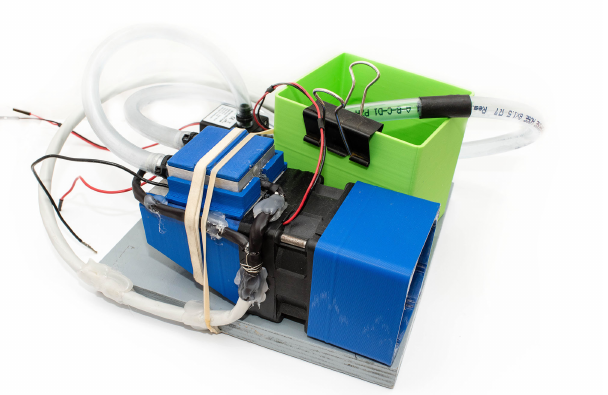
Figure 5. Experimental setup equipped by TEC1-12706. The fan cools the TEG from one side, and hot water is pumped onto the second side of the